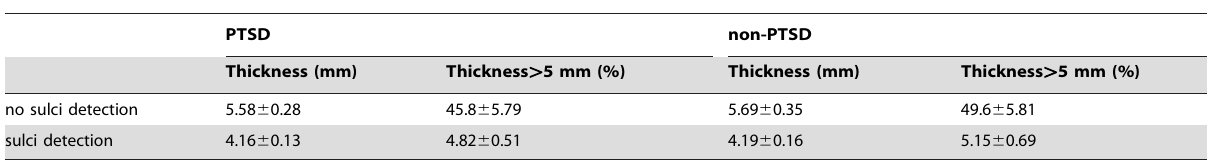
Table 2. Thickness results with and without sulci